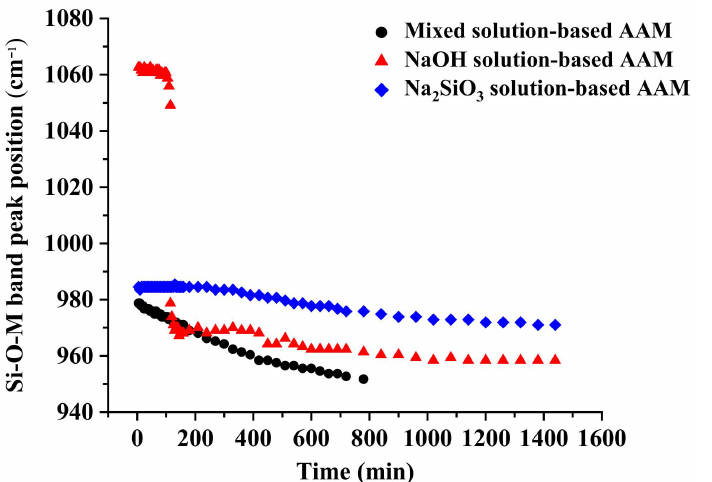
Figure 2. Shifting of the position of the peak of the Si–O–M position as a function of time (M = Si, Al, or